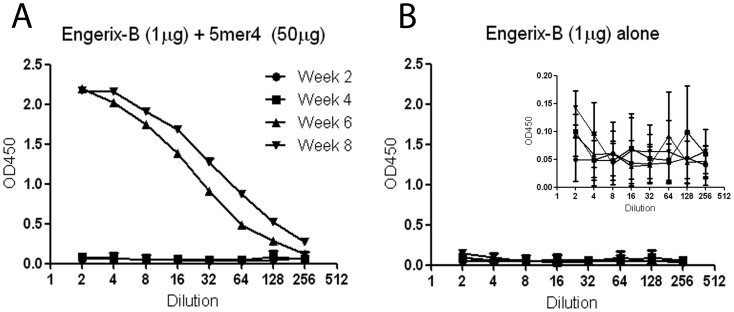
Efficacy of 5mer4 in combination with HBsAg.Exogenous 5mer4 (50 µg) was combined with a commercial Hepatitis B vaccine (Engerix-B, 1 µg). Control mice received the commercial vaccines without 5mer4. Serum was collected from vaccinated animals at 2 •, 4 ▪, 6 ▴, and 8 ▾ weeks post-immunization and evaluated in two-fold dilutions for detection by ELISA. Antibody levels were detected at OD450 nm. (a) Anti-HBsAg antibodies following vaccination with Engerix-B + 5mer4. (b) Anti-HBsAg antibodies following vaccination with Engerix-B alone. Inset displays the data within a more narrow y-axis range. The data represents the arithmetic mean titre ± SEM.